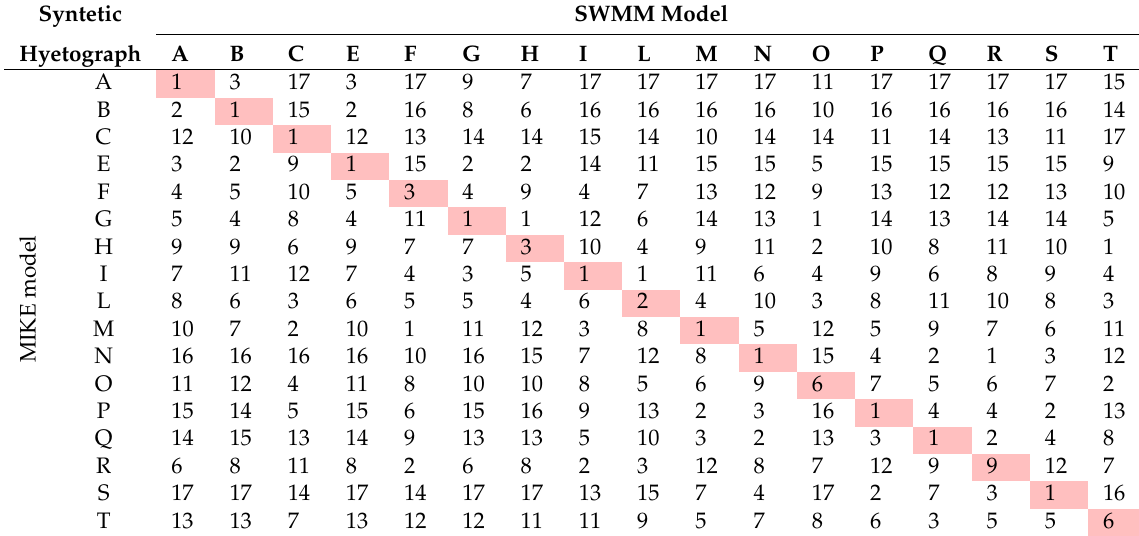
Table 8. Rank matrix of the Euclidean distance of flood maps simulated by SWMM and MIKE models in the Corace torrent (Calabria, Southern